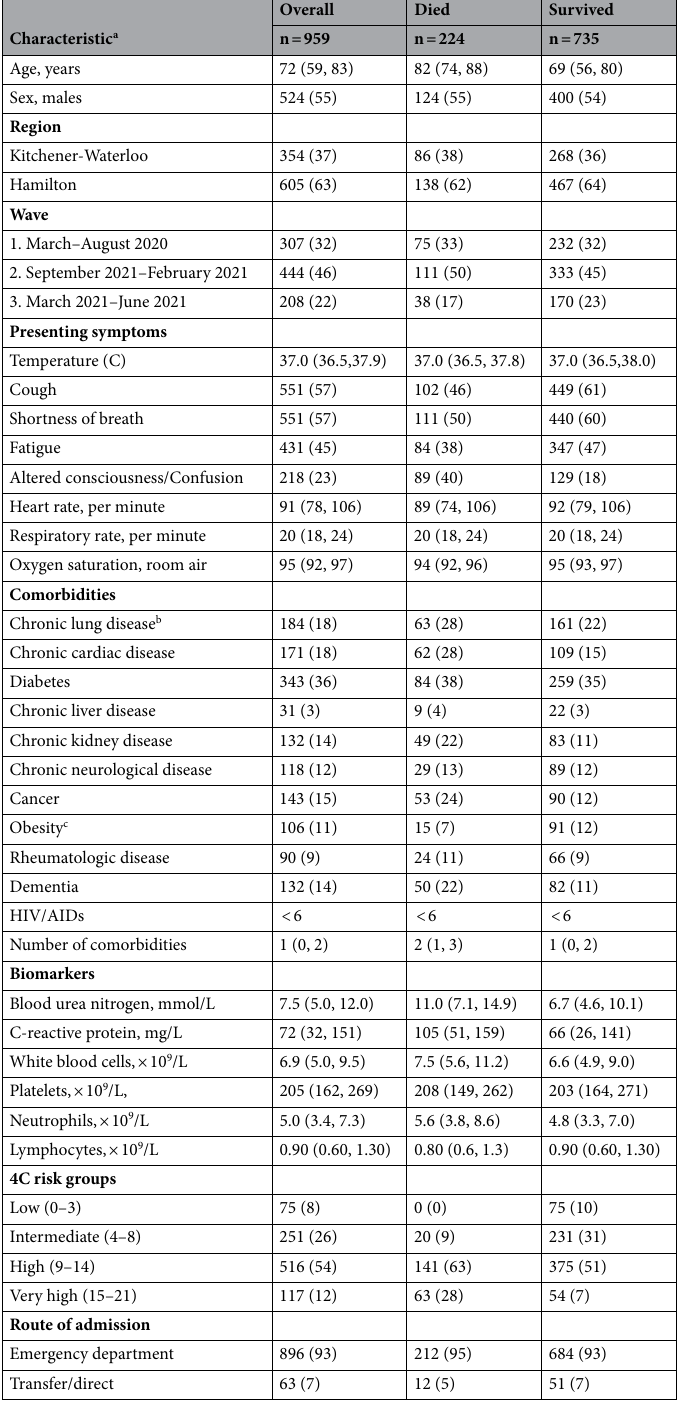
Table 1. Characteristics of COVID-positive hospital inpatients and emergency department patients in the Kitchener-Waterloo region of Canada, March 2020 – January 2021. a Categorical variables presented as n, (%). Continuous variables presented as median (q1, q3). b Does not include asthma. c As defined by